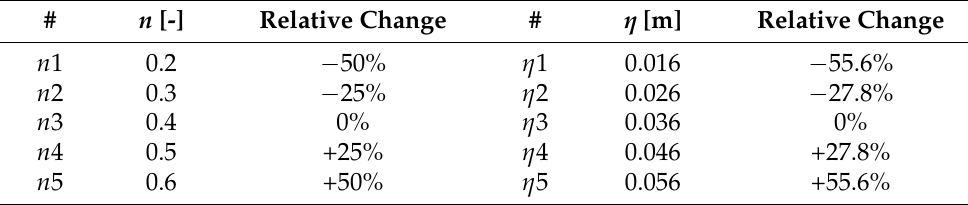
Table 3. Porosity n and porous layer thickness η used for univariate sensitivity analysis.